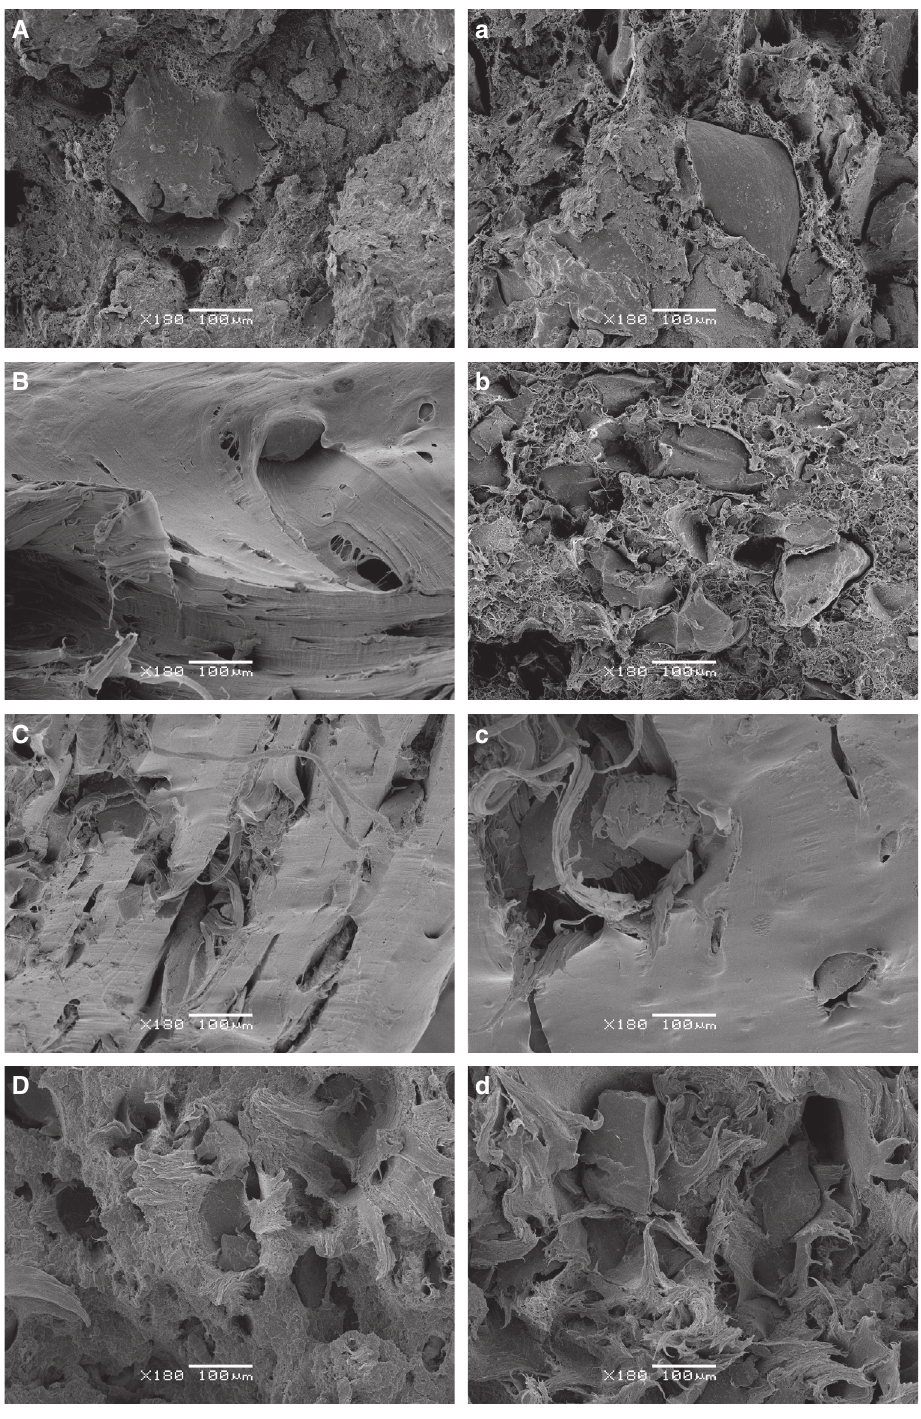
Figure 2 SEM micrographs of polymers/GTR compounds for some polymer/GTR concentrations and particles sizes < 200 μ m.